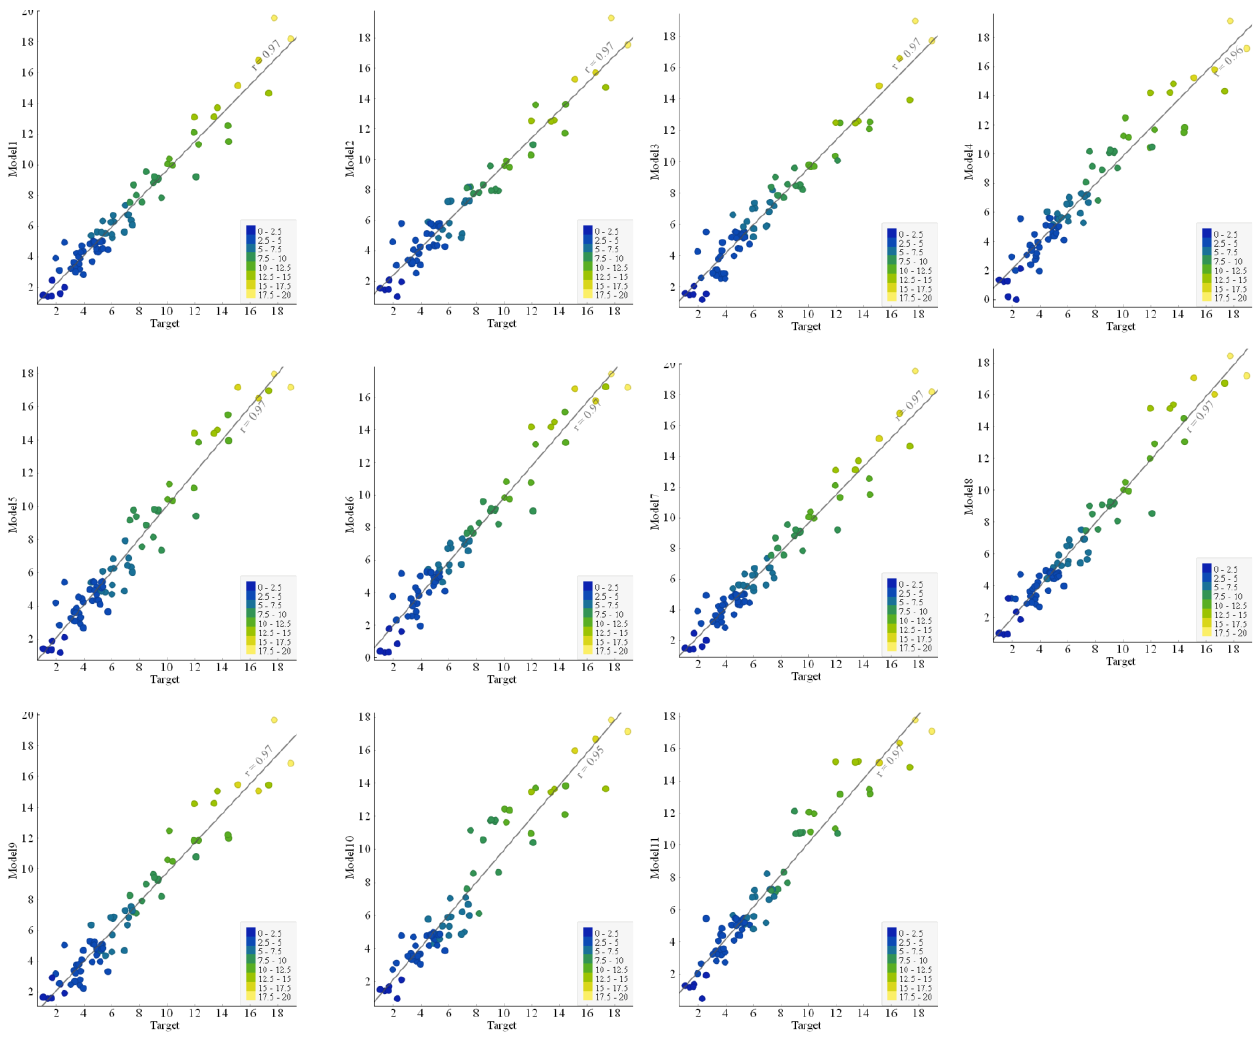
Figure 9. Comparison of the regression slope between experimental and predicted results for the testing data. Table 3. Comparison of frequency ratios of predicted to experimental values for the developed